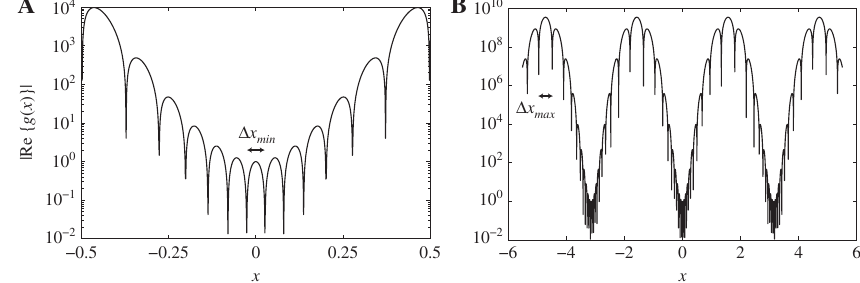
Figure 5: The Berry-Popescu superoscillating function with a = 3, N = 20, for a range (A) −0.5 ≤ x ≤ 0.5 and (B) −5.5 ≤ x ≤